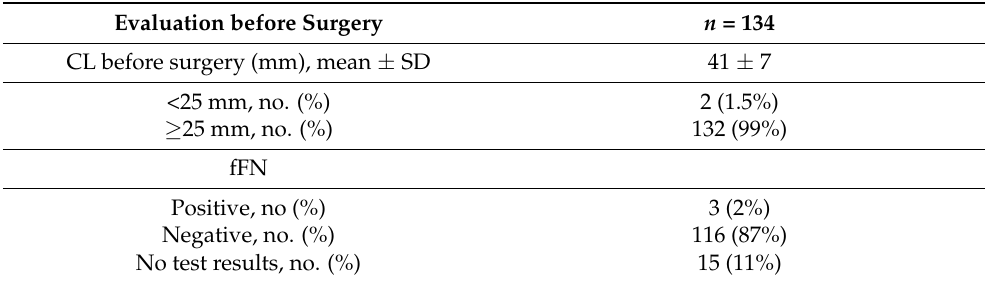
Table 2. Results of cervical length (CL) before surgery and the fetal Fibronectin tests (fFN). Evaluation before Surgery n = 134 CL before surgery (mm), mean ± SD 41 ±